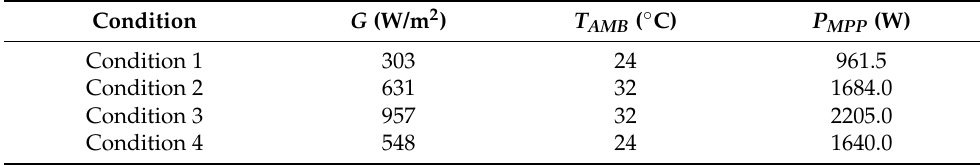
Table 8. Ambient conditions and respective expected P MPP